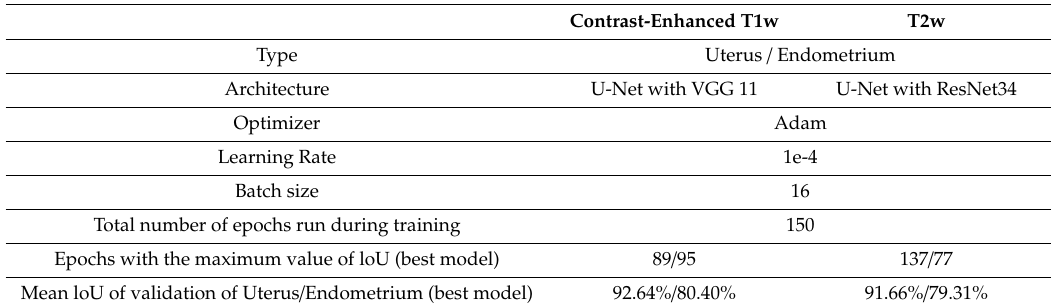
Table A3. Performance of each architecture of the trained CNN models on contrast-enhanced T1w and T2w. The parameters of learning rate, batch size, total epochs, epochs with the best value of IoU and mean IoU of both the uterus and endometrium are